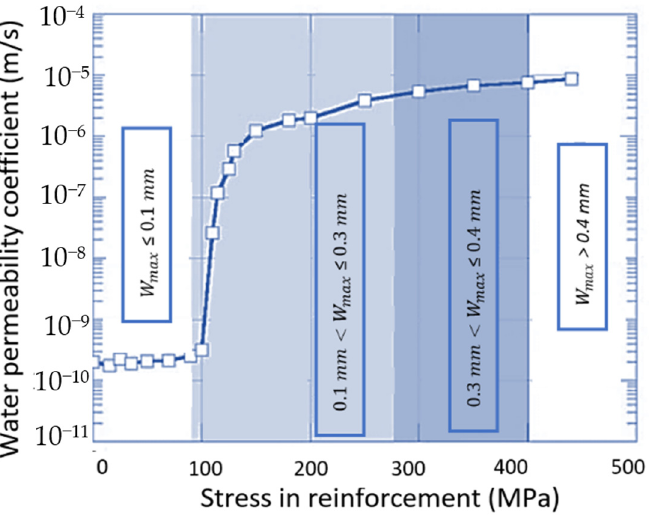
Figure 28. Water permeability result with respect to loading for normal strength concrete (NSC) tie specimens (Adapted with permission from reference [59]).